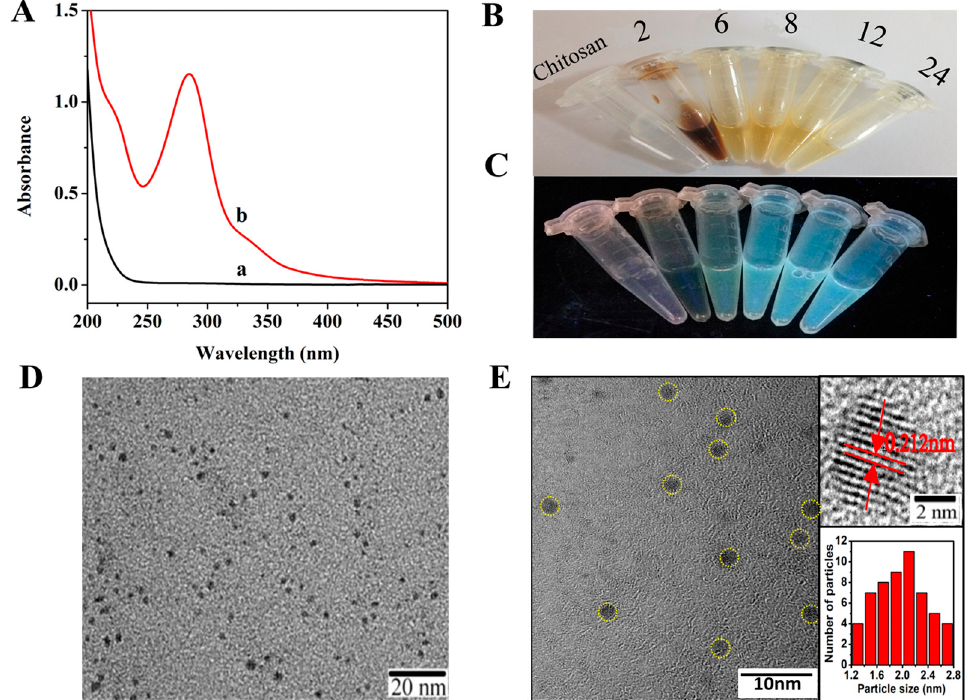
Figure 1. ( A ) Absorption spectra of chitosan (a) and reductive carbon quantum dots (CQDs) (b); ( B ) From left to right are photographs of chitosan, CHI-2, CHI-6, CHI-8, CHI-12 and CHI-24 illuminated by natural light; ( C ) From left to right are photographs of chitosan, CHI-2, CHI-6, CHI-8, CHI-12 and CHI-24 illuminated by an UV lamp with 365 nm light; ( D ) TEM of CQDs (CHI-12); ( E ) HRTRM image and the size distribution histogram of CQDs (CHI-12).